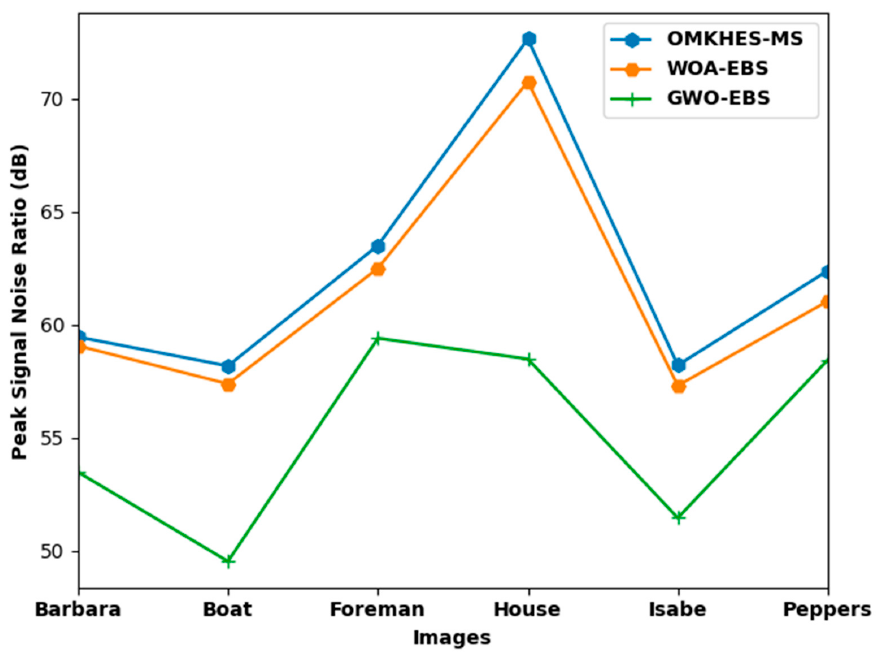
Figure 9. Comparative PSNR analysis of OMKHES-MS technique with existing models.